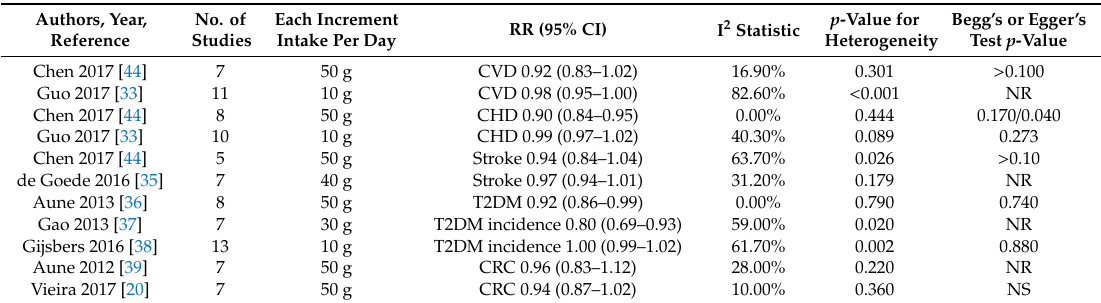
Table 5. Summary of linear dose-response meta-analyses of prospective studies on cheese intake and CVD, CHD, stroke, T2DM, and CRC.